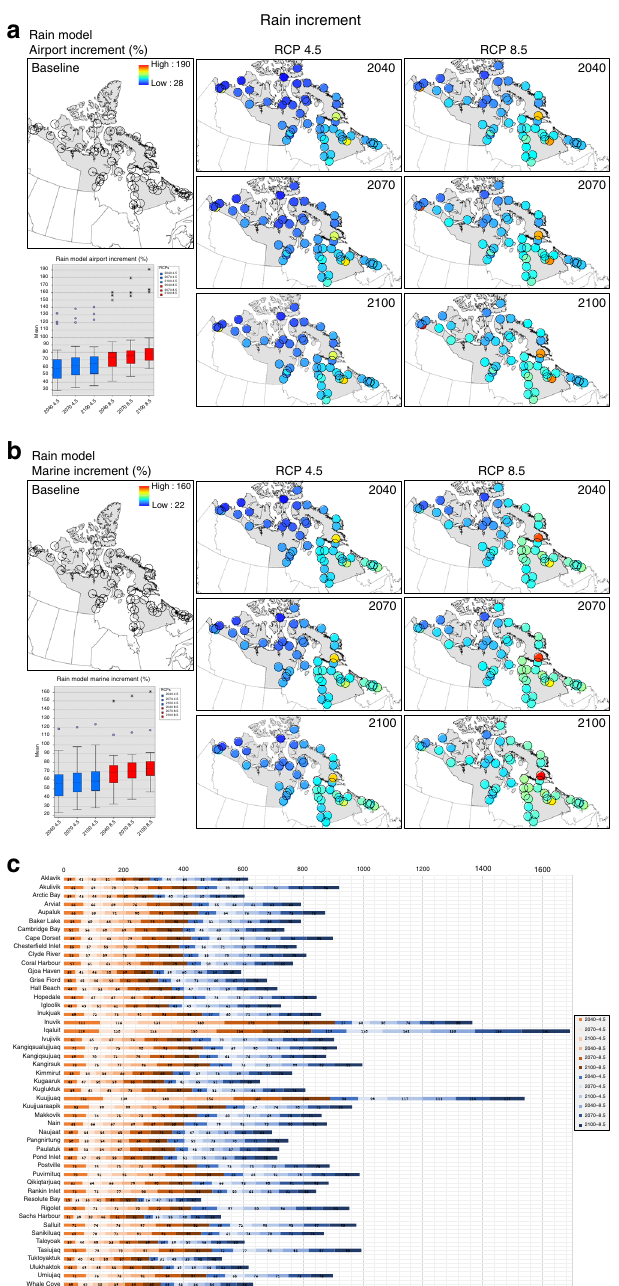
Fig. 5 Rain increment maps. a , b Increment percentage/anomalies for the rain model (airport and marine multiplicative vulnerability equations) including 49 Inuit Nunangat communities and future RCP 4.5 (blue) and 8.5 (red) scenarios (2040, 2070, 2100). Boxplots include mean values, max- min values and outliers. The x -axis represents the scenarios and the y -axis the mean increment/anomalies values in percentage. The blank baseline map means that there are no baseline values for the increment